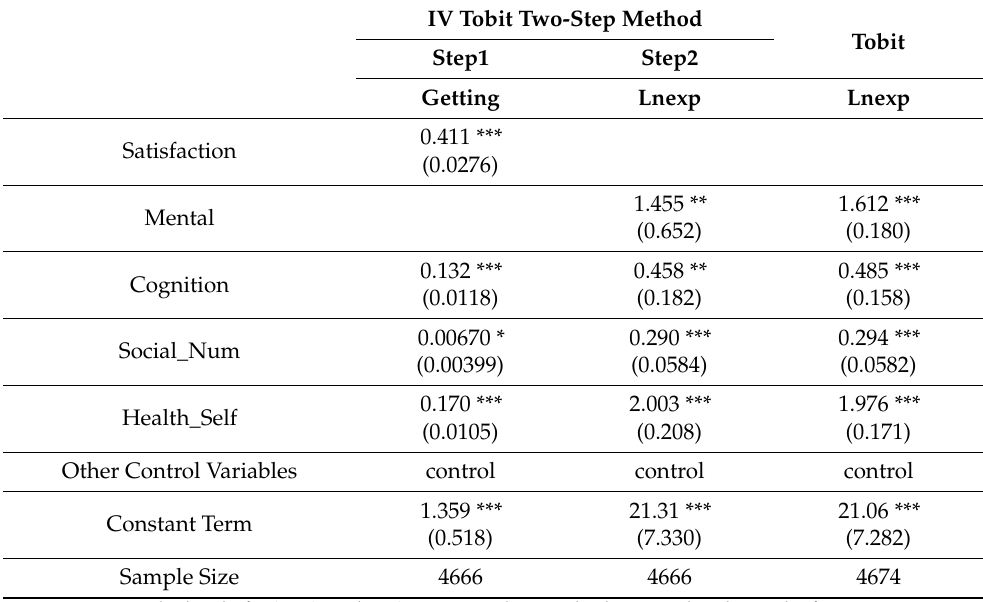
Table 7. Results of Tobit two-step